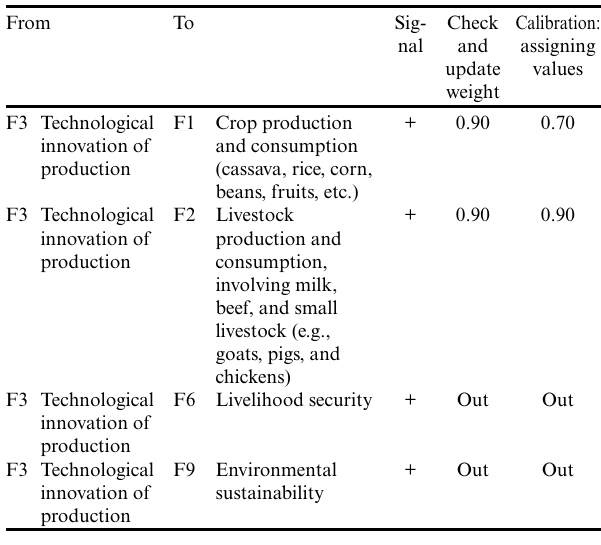
Table 4 . Example of the relationships and weights from the livestock